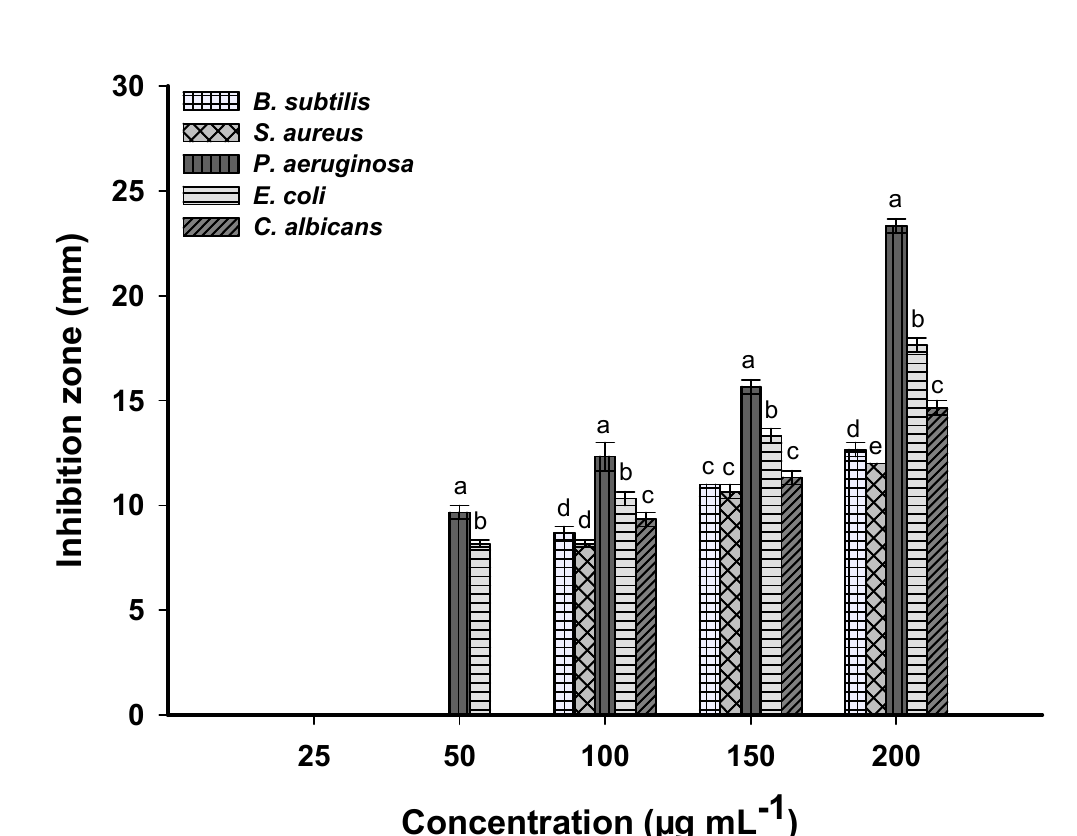
Figure 5. Antimicrobial activity of biosynthesized MgO-NPs against pathogenic Gram-positive and Gram-negative bacteria, and unicellular fungi. Different letters (a, b, c, d and e) on bars at the same concertation denote that mean values are significantly different ( p ≤ 0.05) (n = 3).